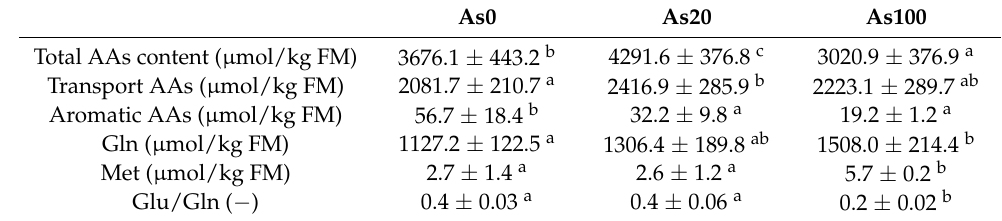
Table 2. Content of free amino acids in tubers of cherry radish. Values represent the mean ± SD. Data with the same letter are not significantly different. Different letters indicate significant differ- ences ( p < 0.05) among treatments according to ANOVA with Tukey’s post-hoc test. Abbreviations: As0—0 mg As/kg soil (control); As20—20 mg As/kg soil; As100—100 mg As/kg soil; AAs—amino acids; Gln—free glutamine; Glu—free glutamate; Met—free methionine; FM—fresh matter. As0 As20 As100 Total AAs content ( µ mol/kg FM) 3676.1 ± 443.2 b 4291.6 ± 376.8 c 3020.9 ± 376.9 a Transport AAs ( µ mol/kg FM) 2081.7 ± 210.7 a 2416.9 ± 285.9 b 2223.1 ± 289.7 ab Aromatic AAs ( µ mol/kg FM) 56.7 ± 18.4 b 32.2 ± 9.8 a Gln ( µ mol/kg FM) Met ( µ mol/kg